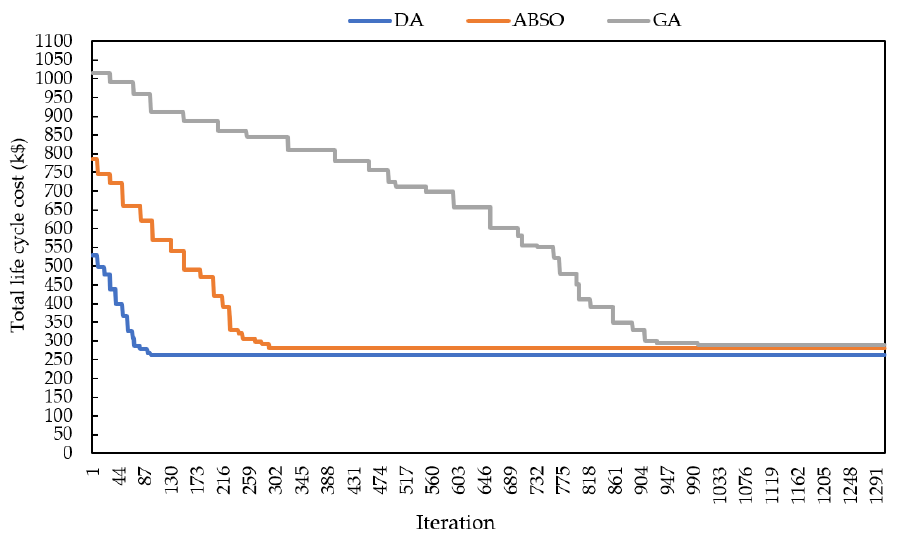
Figure 9. Convergence speed of the DA, GA, and ABSO optimization algorithms.